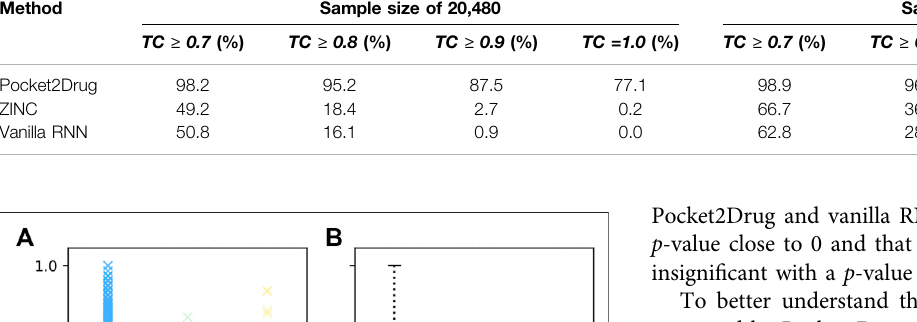
TABLE 3 | Hit rates for the Pocket2Drug-lowhomol dataset. Method